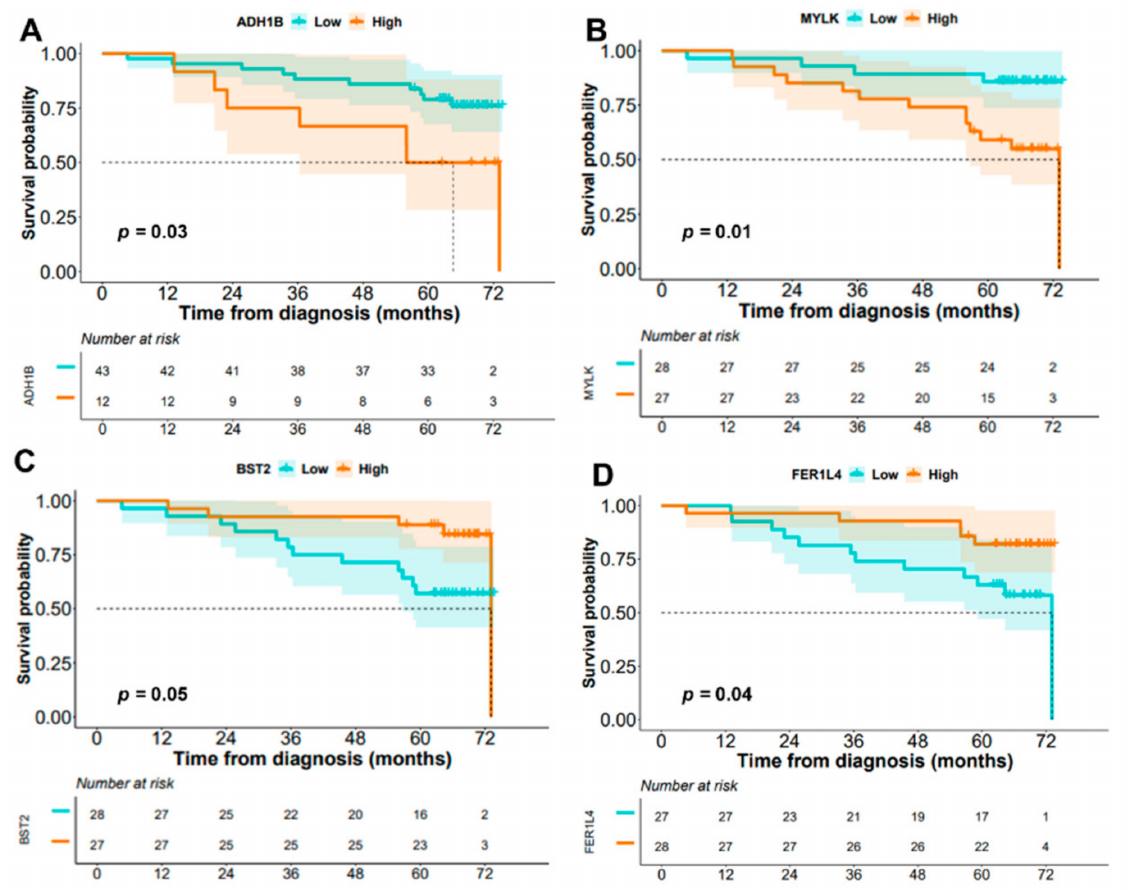
Figure 4. Genetic features of sCRC patients showing the impact on overall survival (OS) in the univariate analysis (n = 55). ( A ) ADH1B gene (NM_001286650), ( B ) MYLK gene (NM_053026), ( C ) BST2 gene (NM_004335), and ( D ) FER1L4 pseudogene